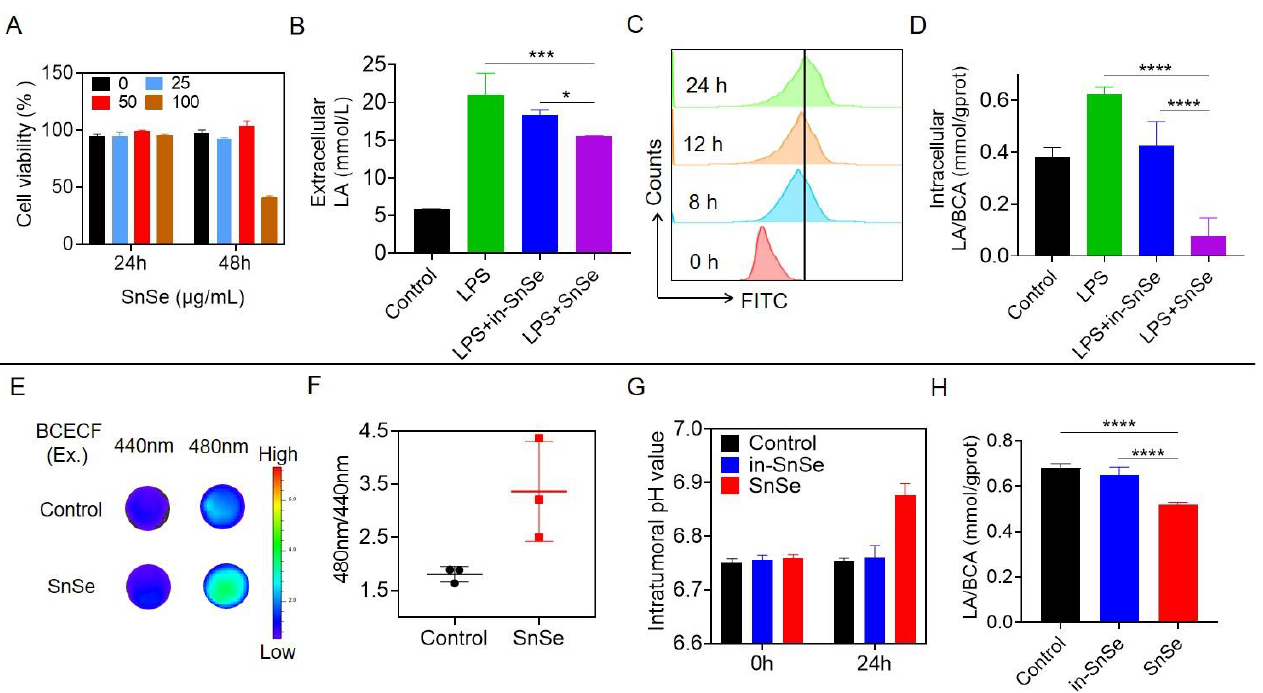
Figure 2. Analyses of lactate consumption behaviors of SnSe NSs. ( A ) Cell viability of RAW 264.7 cells after treatment with various concentrations of SnSe NSs. ( B ) RAW 264.7-cell extracellular lactate levels under LPS treatments with the addition of SnSe NSs and in-SnSe NSs for 24 h. ( C ) Flow cytometric assay of cell uptake of SnSe NSs at different time points. ( D ) The evaluation of intracellular lactate levels in RAW 264.7 cells in the presence of LPS treatments after incubation with SnSe NSs and in-SnSe NSs for 24 h. ( E ) In vivo fluorescence imaging of tumor tissue supernatant injected with SnSe NSs after 24 h. ( F ) Semiquantitative analysis of pH fluorescence intensities based on the imaging data shown in (E). ( G ) Intratumoral pH value of tumors at 0 and 24 h post-intravenous injection of SnSe NSs and in-SnSe NSs. ( H ) The lactate consumption level after different treatments in vivo. Data are means ± SDs. Statistical significance was calculated using one-way ANOVA followed by Tukey’s post-test. p -value: * p < 0.05; *** p < 0.001; **** p < 0.0001. a.u., arbitrary